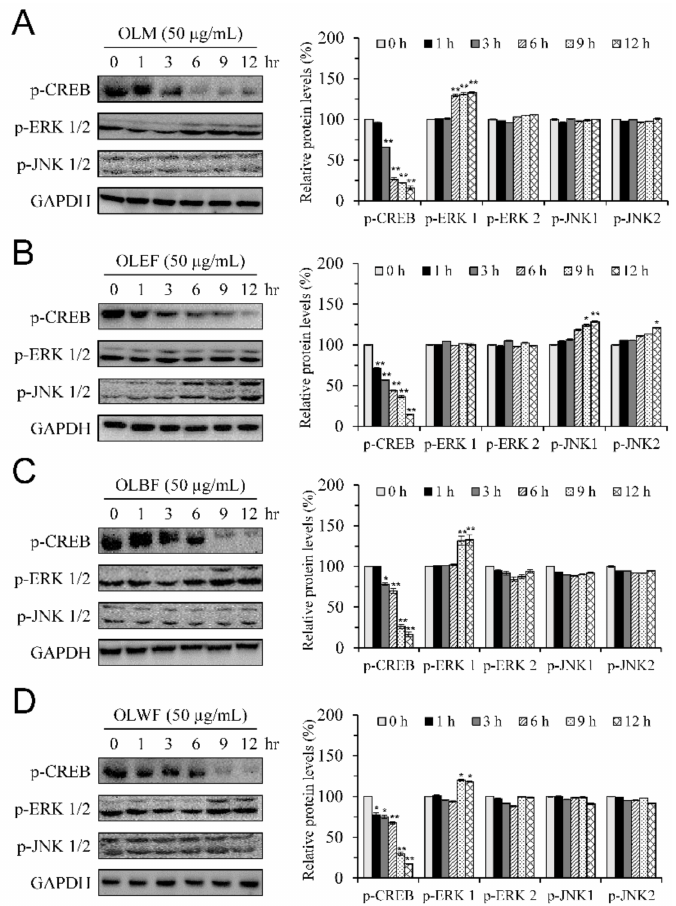
Figure 5. Effects of OLM ( A ) and its fractions, OLEF ( B ), OLBF ( C ), and OLWF ( D ), on the phos- phorylation levels of CREB, ERK1/2, and JNK1/2 in B16-F10 cells. B16-F10 melanoma cells were treated with 50 µ g/mL of test samples for for 1, 2, 6, 9, and 12 h: left panels are representative immunoblots. Right panels are densitometry analyses of the relative ratio of phosphorylated-protein (p-protein)/GAPDH protein, represented as percentages of the control group. Columns, mean ± SD of three independent experiments. * p < 0.05, ** p < 0.01, compared with control